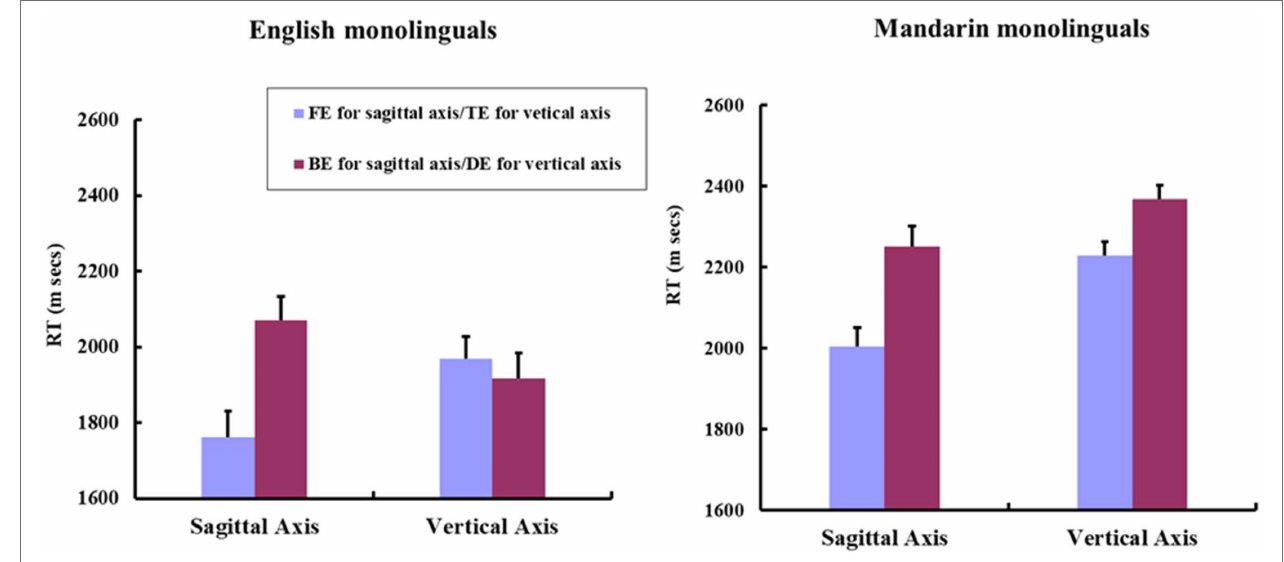
FIGURE 3 | Mean RTs for FE and BE mouse mappings along the sagittal axis; TE and DE mouse mappings along the vertical axis by English and Mandarin monolinguals. The figure plotted by participants’ mean RTs. Error bars indicate standard errors of the